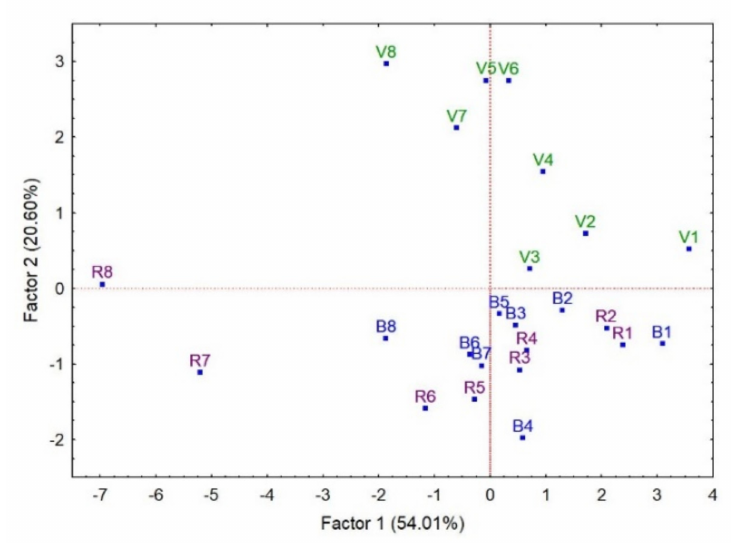
Figure 6. Principal components analysis of control virgin olive oils (V1-V8) and flavoured with basil (B1-B8) and rosemary (R1-R8). Numbers mean the month order in the storage experiment. Data were fully standardized to diminish the weight of the phenols with high vs. with low concentrations in the statistical